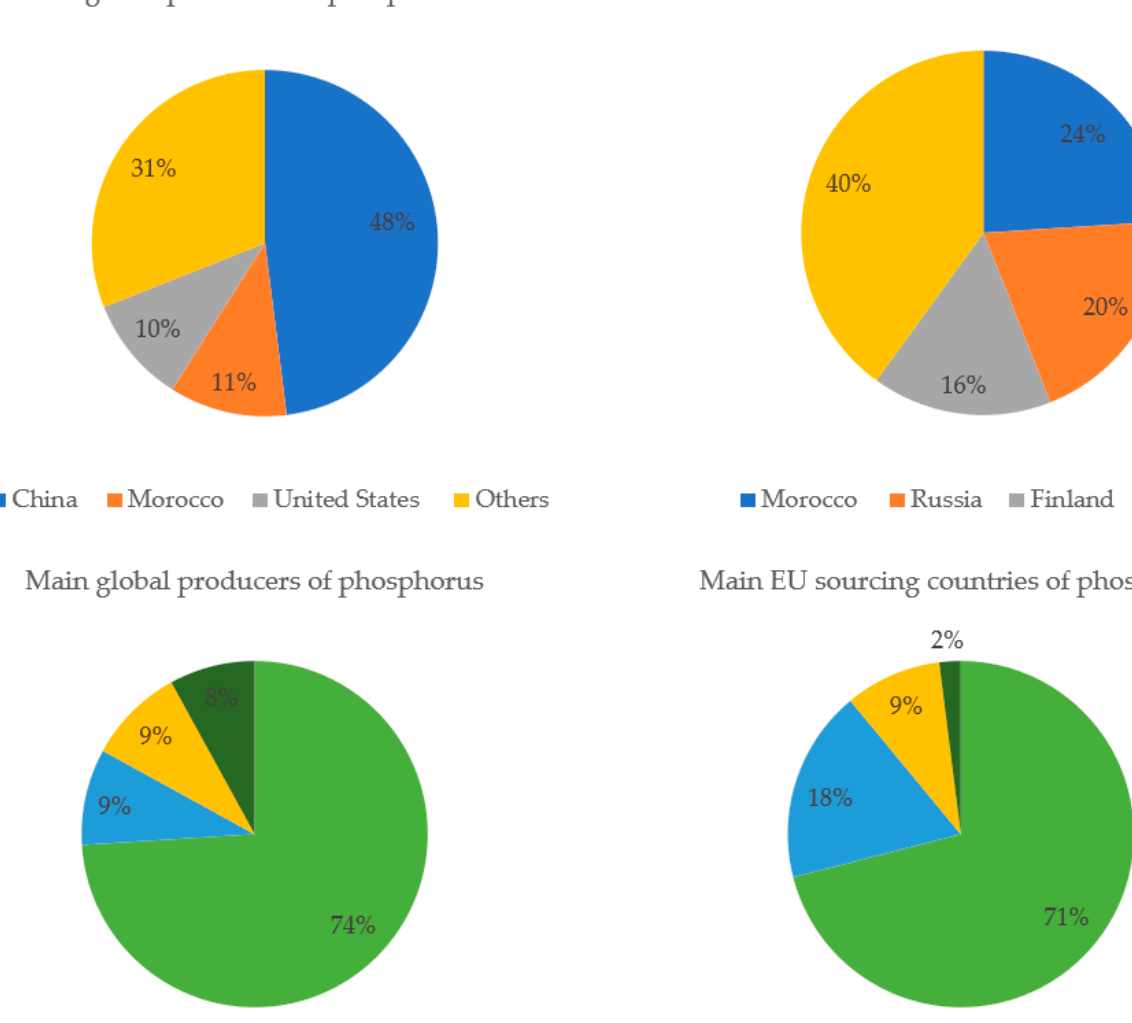
Figure 2. Structure of global producers and main EU sourcing countries of phosphorus and phosphate rock, own analysis based on [19].